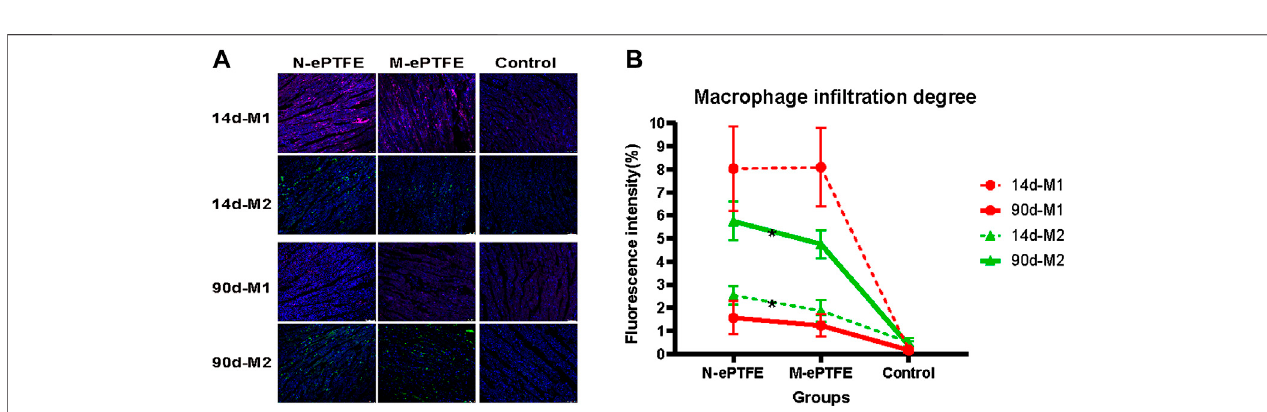
FIGURE 9 | Macrophage in fi ltration in the myocardium (A) Immuno fl uorescence showing distribution of M1 and M2 type macrophages in the myocardium in the three groups: purple, CD86-labeled M1;green, CD206-labeled M2;blue, nuclei (B) Quanti fi cation ofthedegrees ofM1and M2 in fi ltration at postoperative days 14and 90 ( n = 6; *p < 0.05). N-ePTFE/M-ePTFE, unmodi fi ed/modi fi ed expanded polytetra fl uoroethylene; Control: No